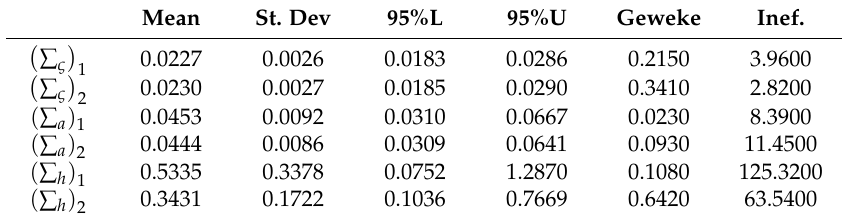
Table 4. Estimation of selected parameters in the time-varying parameter TVP-VAR model (bank credit–housing